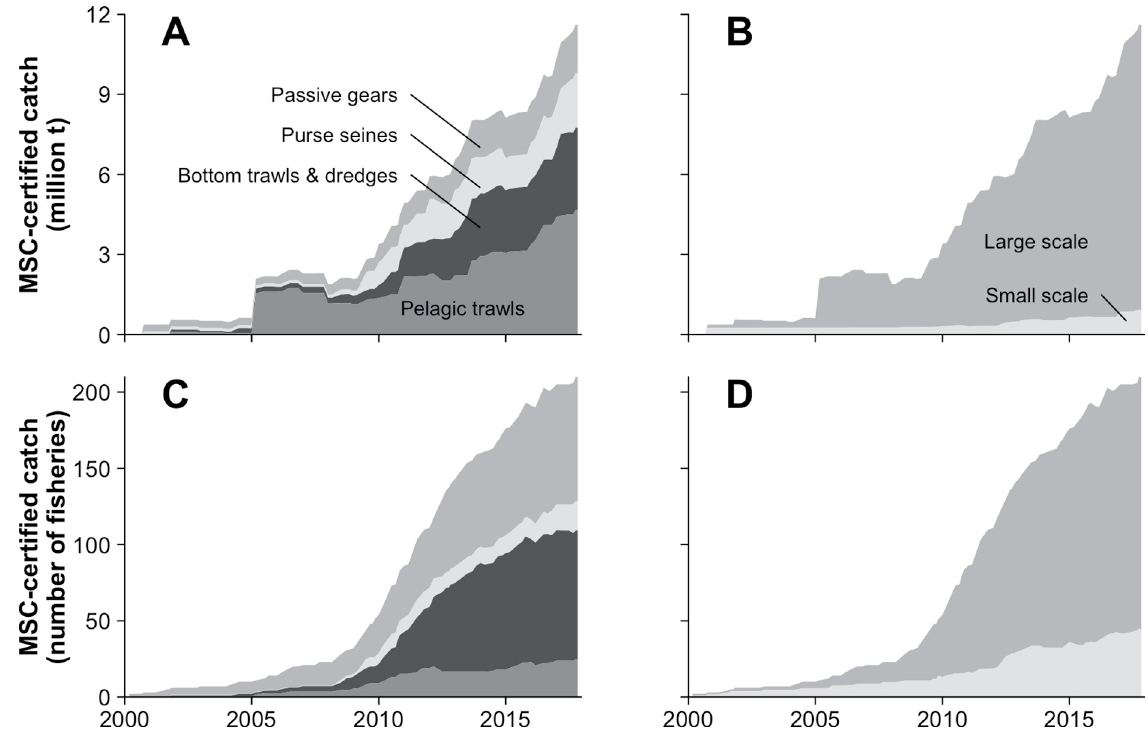
Fig 2. Evolution of MSC-certified catch by gear (A: in catch; C: in number) and scale (B: in catch; D: in number), 2000–2017. The ’Passive gears’ category in panels A and C includes entangling nets, longlines and other hooks & lines, pots & traps, and other hand-operated gears (e.g. beach seines, hand